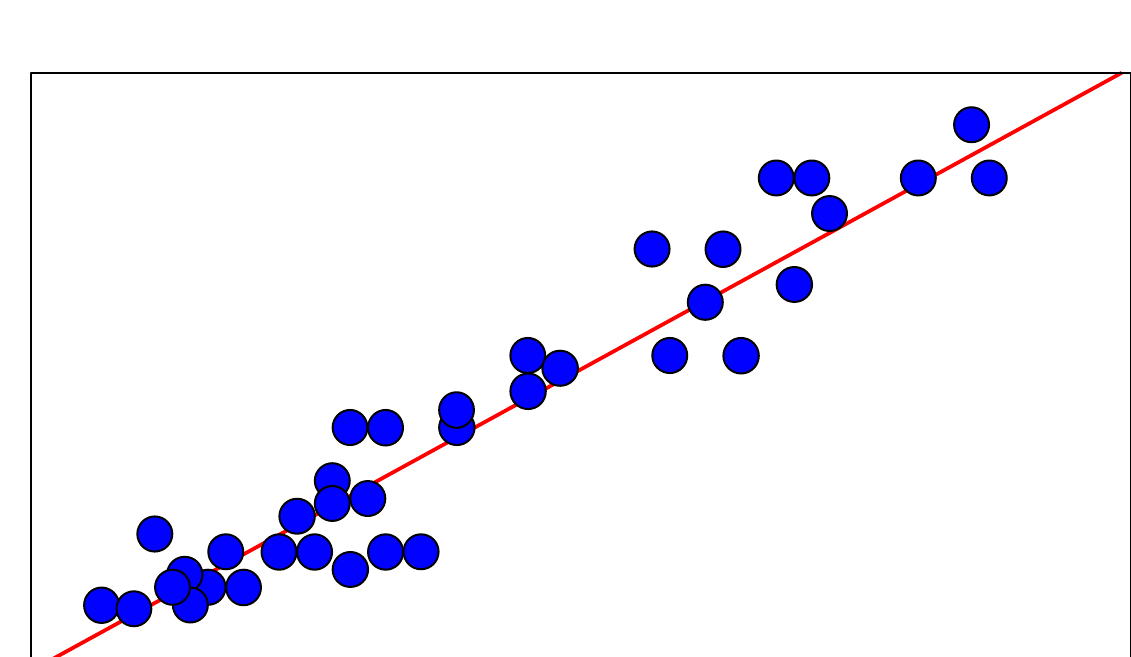
Figure 5. The correlation of predicted logKi (logKi-cv) Calculated using the cross validation method with 'leave one out' procedure and observed logKi